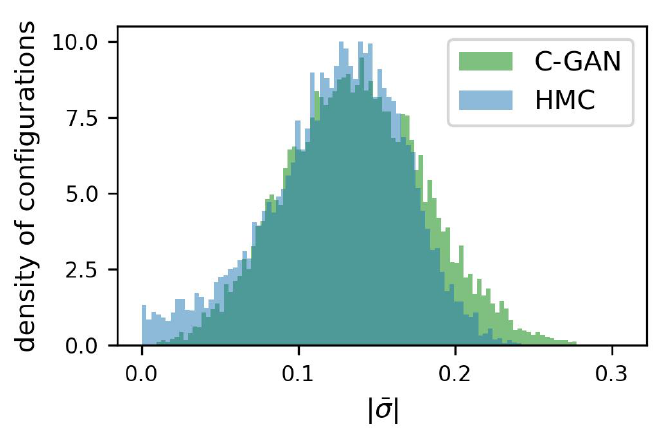
Figure 15: Histogram of | ¯ σ | at λ = 1.55 ∈ Λ ts quite well.